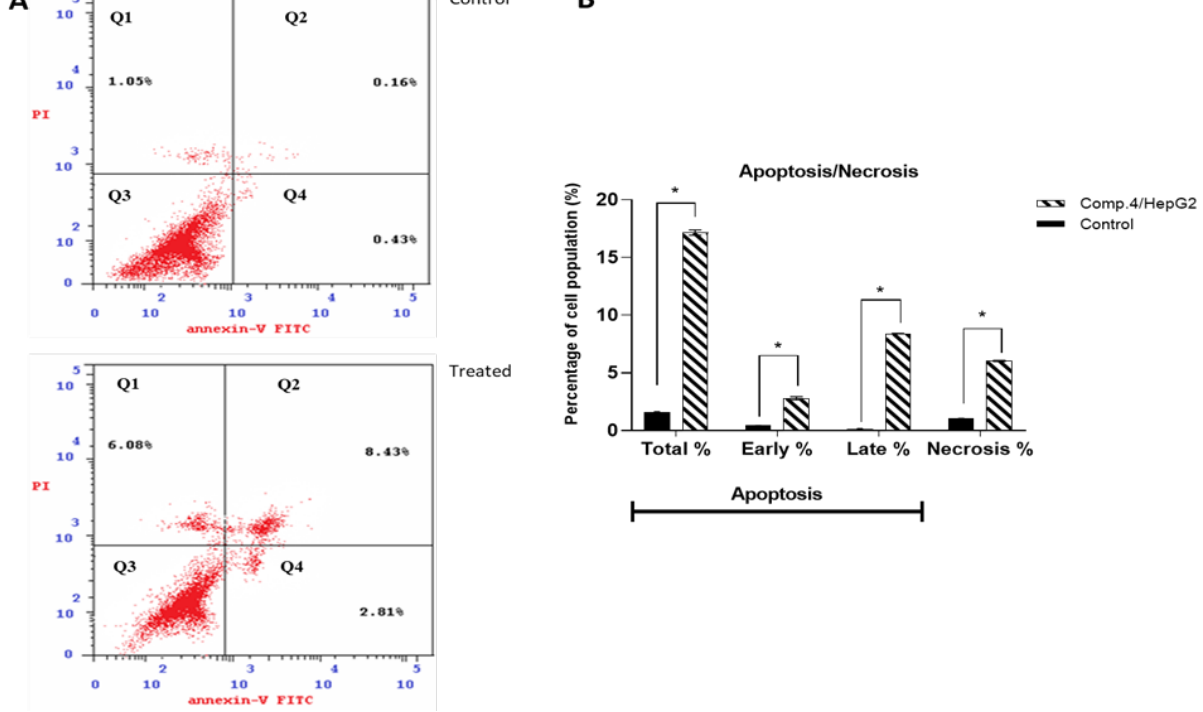
Figure 4. ( A ) Compound 4 induces apoptosis using FITC/annexin-V-FITC/PI differential apopto- sis/necrosis. Quadrant charts show Q1 (necrotic cells, AV − /PI+), Q2 (late apoptotic cells, AV +/PI+), Q3 (normal cells, AV − /PI − ), Q4 (early apoptotic cells, AV+/PI − ). ( B ) Bar representation of apoptosis percentages of untreated and treated HepG2 cells with compound 4 (IC 50 = 0 .017 μM) in early, late, and total. Values are represented by mean ± SE ( n = 3 independent samples per group). * Significant difference between control and treated groups using unpaired Student’s t-test ( p ≤ 0.05) using SPSS Version 22.